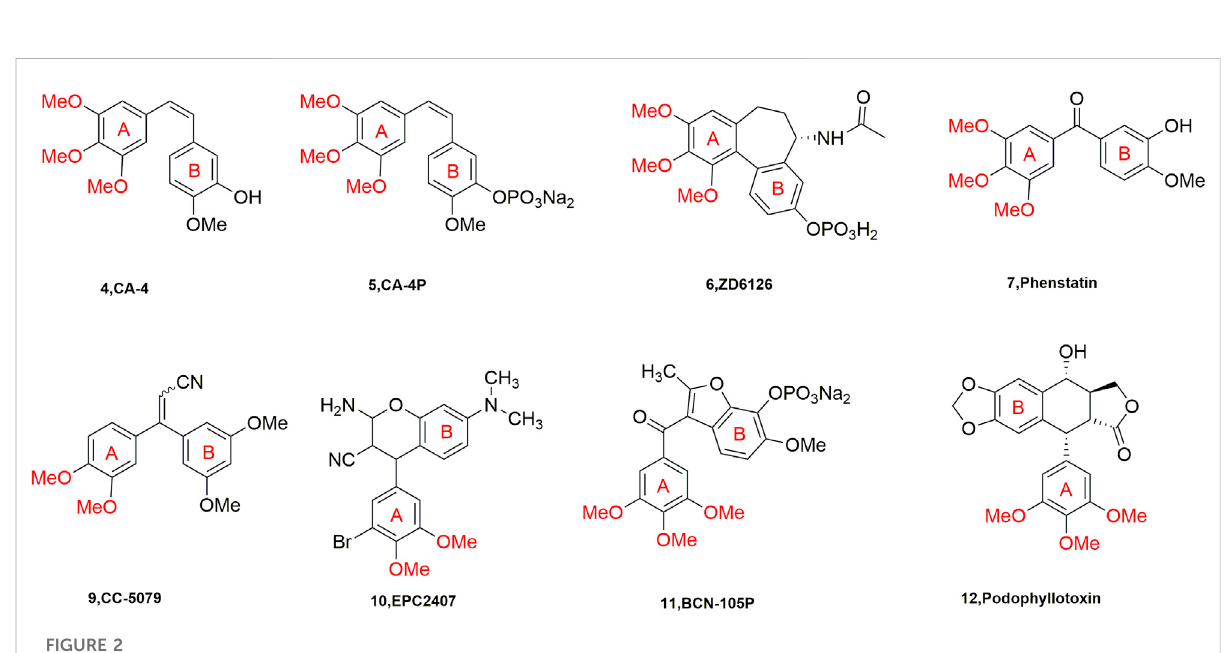
Chemical structures of some CBSIs (currently in clinical